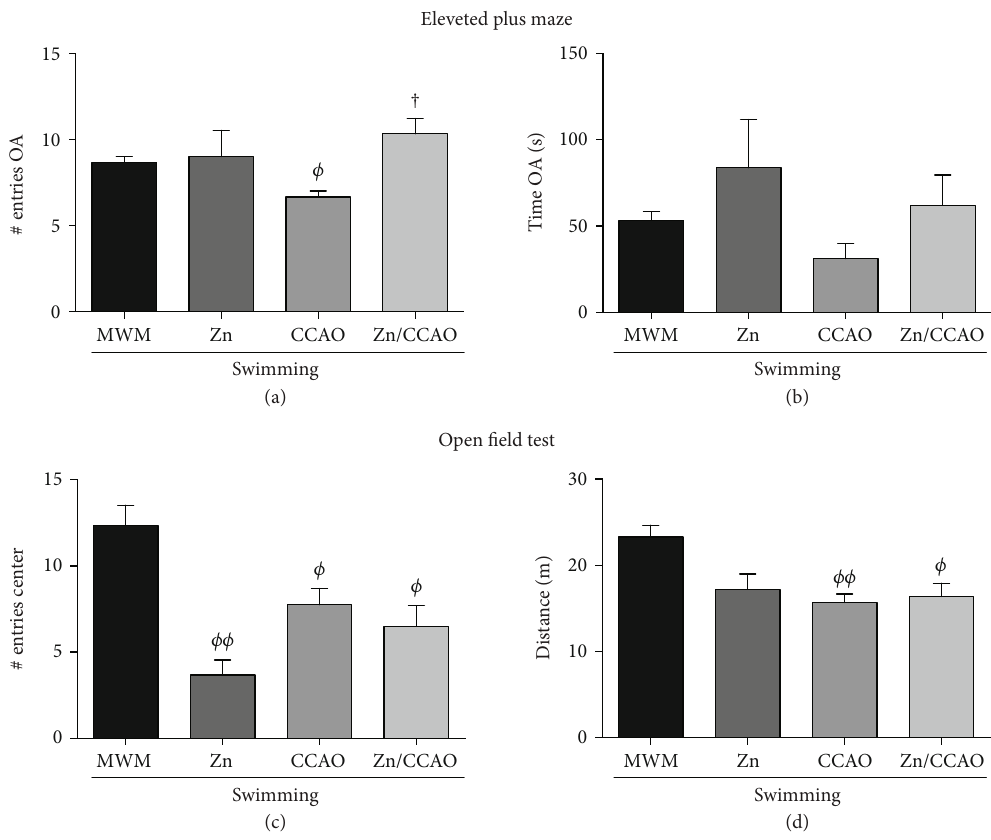
Figure 3: The subacute prophylactic zinc administration prevented emotional disturbance but not mobility alterations in rats with a 30min CCAO on day 30 postreperfusion. The values are mean ± SEM ( n = 4 ) and analyzed with t -test and Welch ’ s post hoc. P < 0 : 05 , Φ compared with the MWM group and † compared with the CCAO group. OA: open Table 3: Hierarchization score of the protective e ff ect of pharmacological strategies (HSPEPS) in cognitive test.